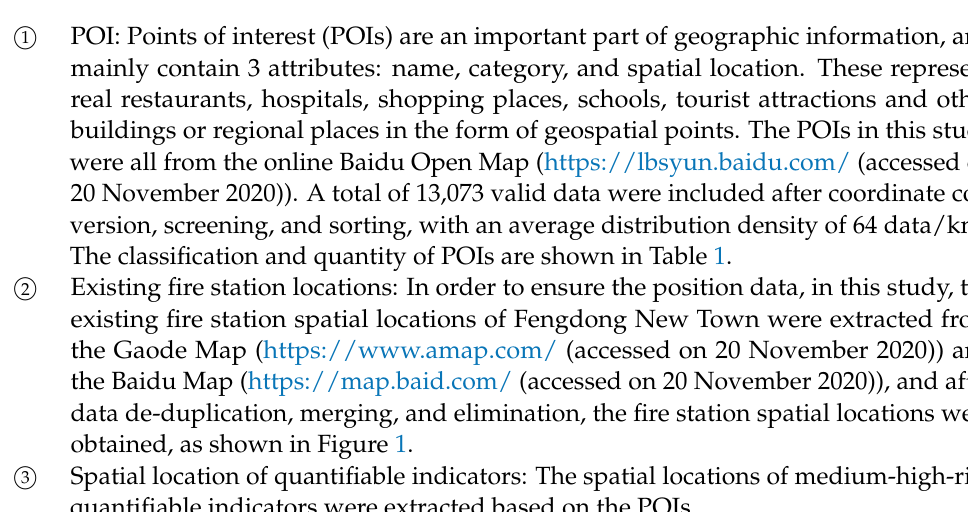
Figure 1. The geographical location of Fengdong New Town and the locations and spatial distribution of fire stations in the region.